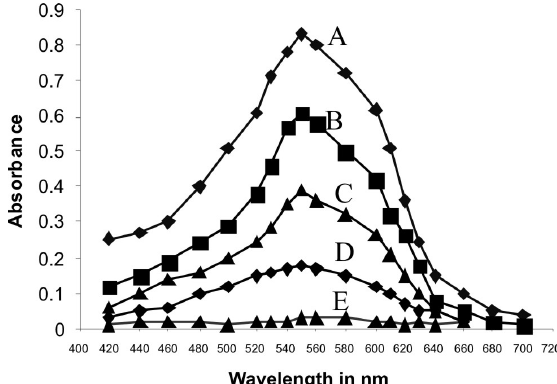
FIGURE 2 - Effect of OLP concentration on the absorbance of 60 µg mL -1 KMnO (A.0.0; B.5.0; C.10.0; D.15.0 and 4 E.20 µg mL -1